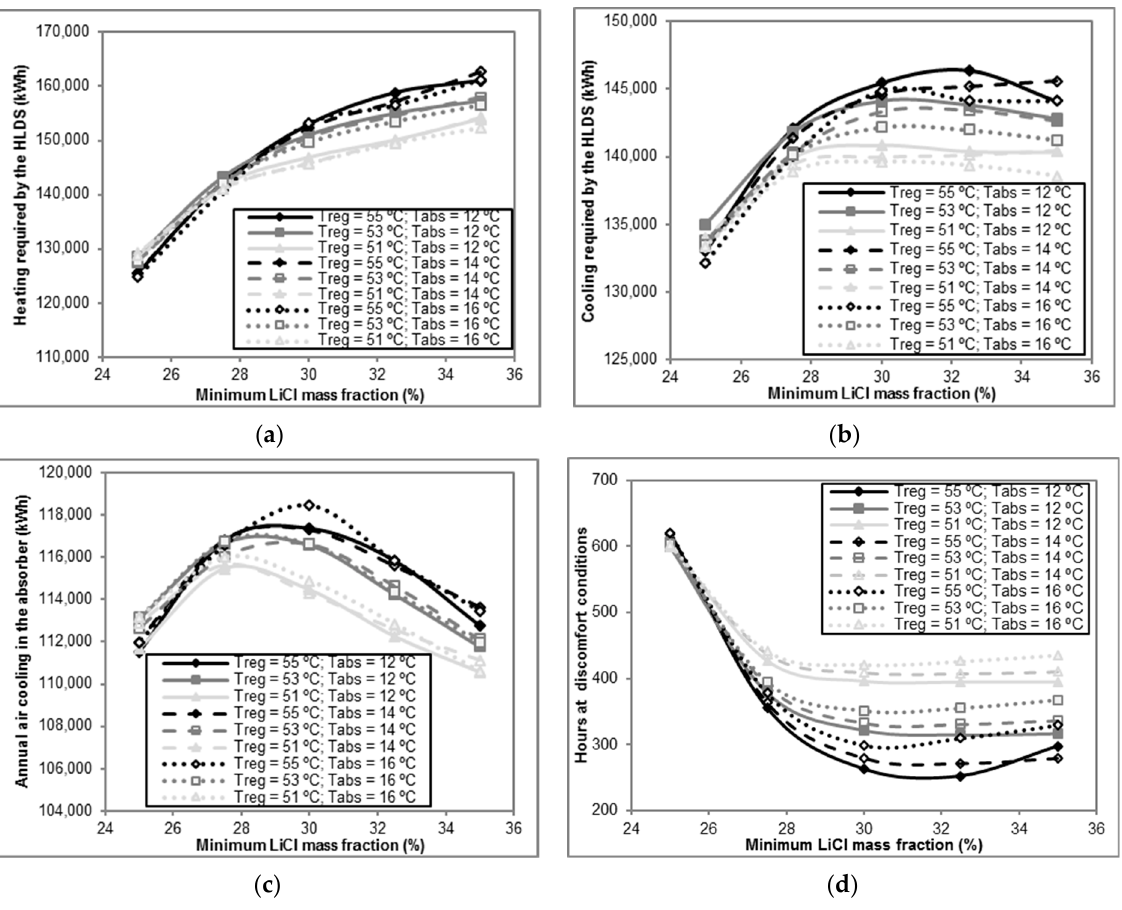
Figure 8. Annual heating required by the HLDS ( a ), annual cooling required by the HLDS ( b ), annual air cooling in the absorber ( c ) and the number of hours at discomfort conditions ( d ) as a function of the minimum LiCl mass fraction, the inlet water temperatures in the absorber, regenerator and the heating and cooling coil.